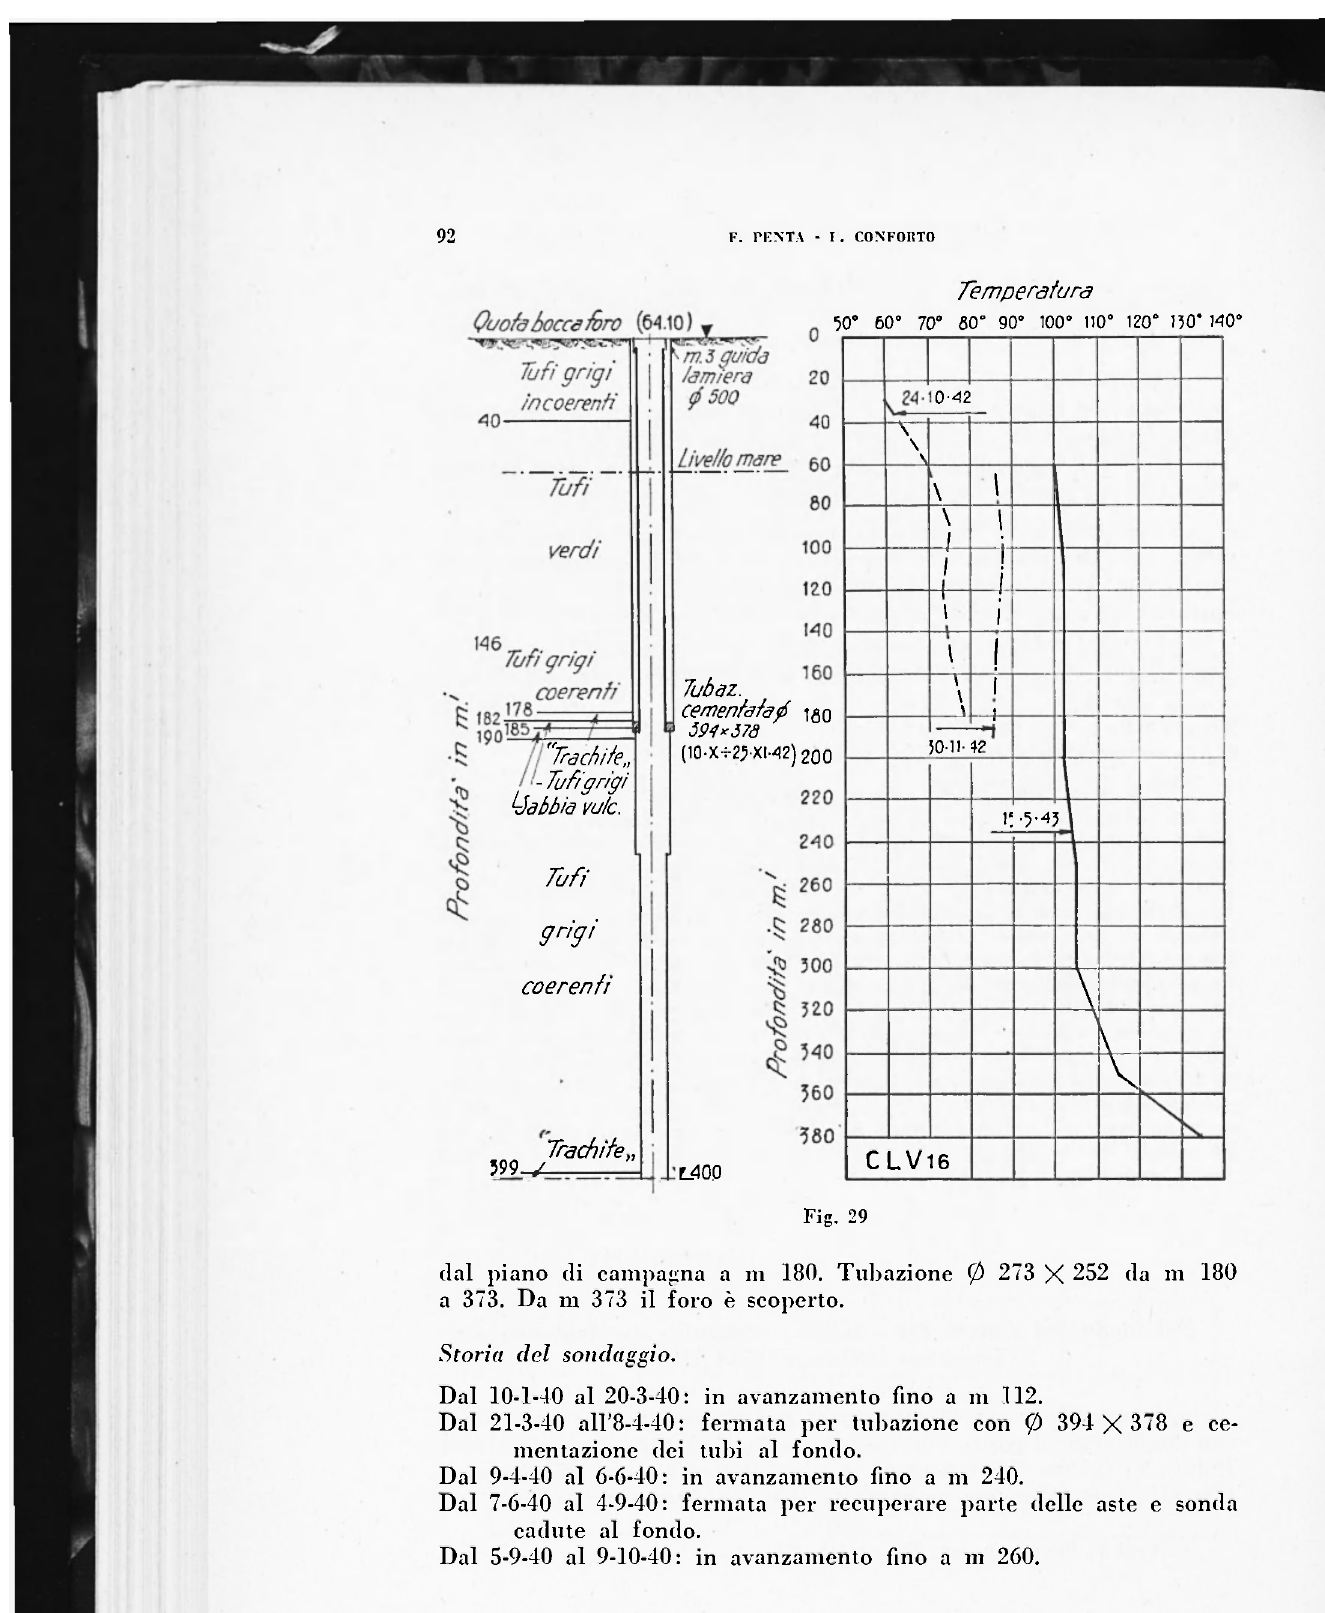
dal piano di campagna a m 180. Tubazione 0 273 X 252 da m 180 a 373. Da 111 373 il foro è scoperto.